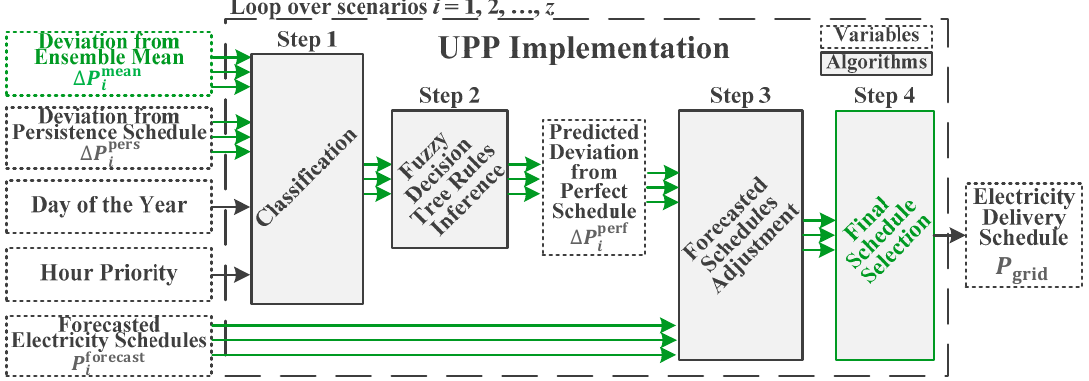
Figure 9. Uncertainty post-processing implementation scheme, with the adaptations of the probabilistic approach highlighted in green.